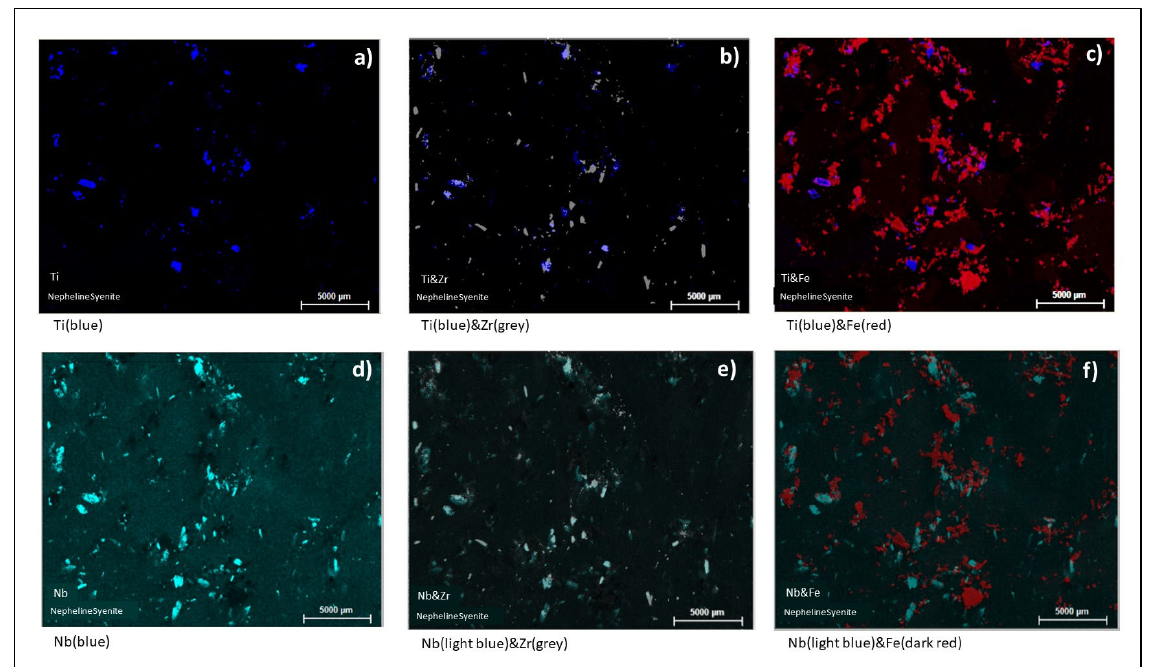
Figure 12. Elemental spatial micrometric distribution of ( a ) Ti, ( b ) Ti&Zr, ( c ) Ti&Fe, ( d ) Nb, ( e ) Nb&Zr, and ( f ) Nb&Fe.